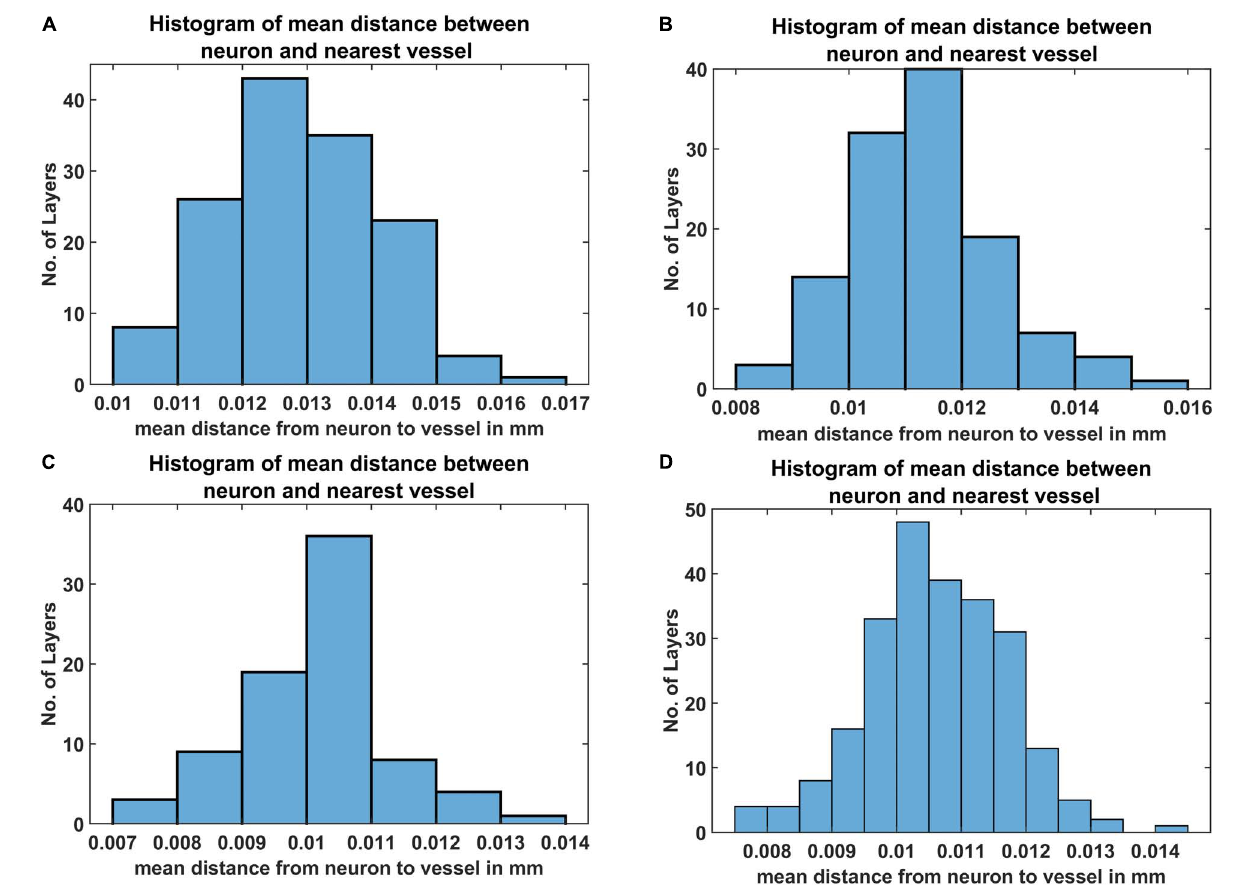
FIGURE 9 | The histogram of mean distance between neurons and the nearest vascular leaf nodes. The measurements are from four regions namely (A) agranular cortex which was measured 1 mm anteroposterior and 1 mm mediolateral of the Bregma, (B) partially granular cortex measured –1 mm anteroposterior and 1 mm mediolateral of the Bregma, (C) partially granular cortex measured 2 mm anteroposterior and 1 mm mediolateral of the Bregma, and (D) granular cortex measured 1 mm anteroposterior and 4 mm mediolateral of the Bregma.